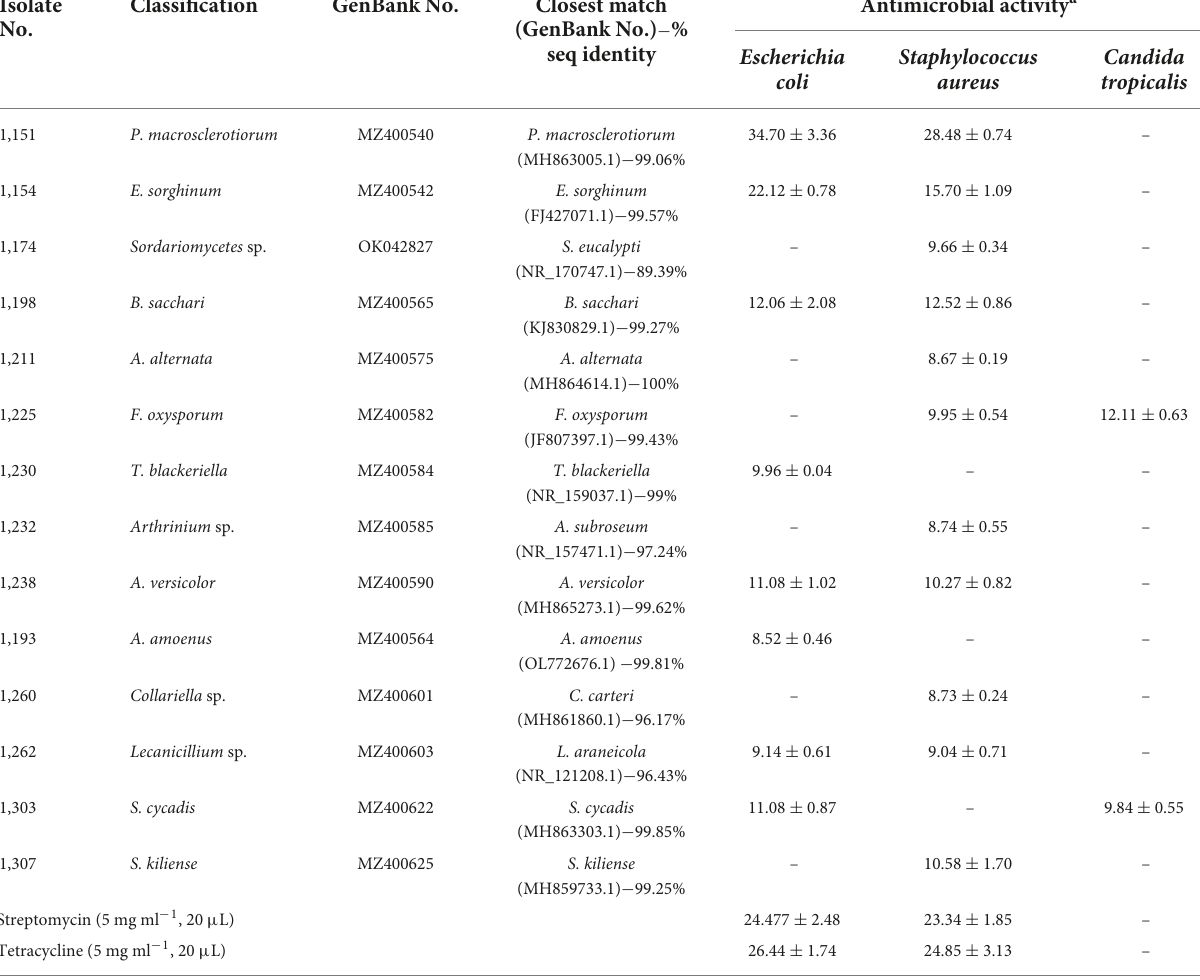
TABLE 2 Antimicrobial activity of 14 endophytic fungi isolated from Nervilia fordii against human pathogenic microorganisms by agar well diffusion method. Isolate